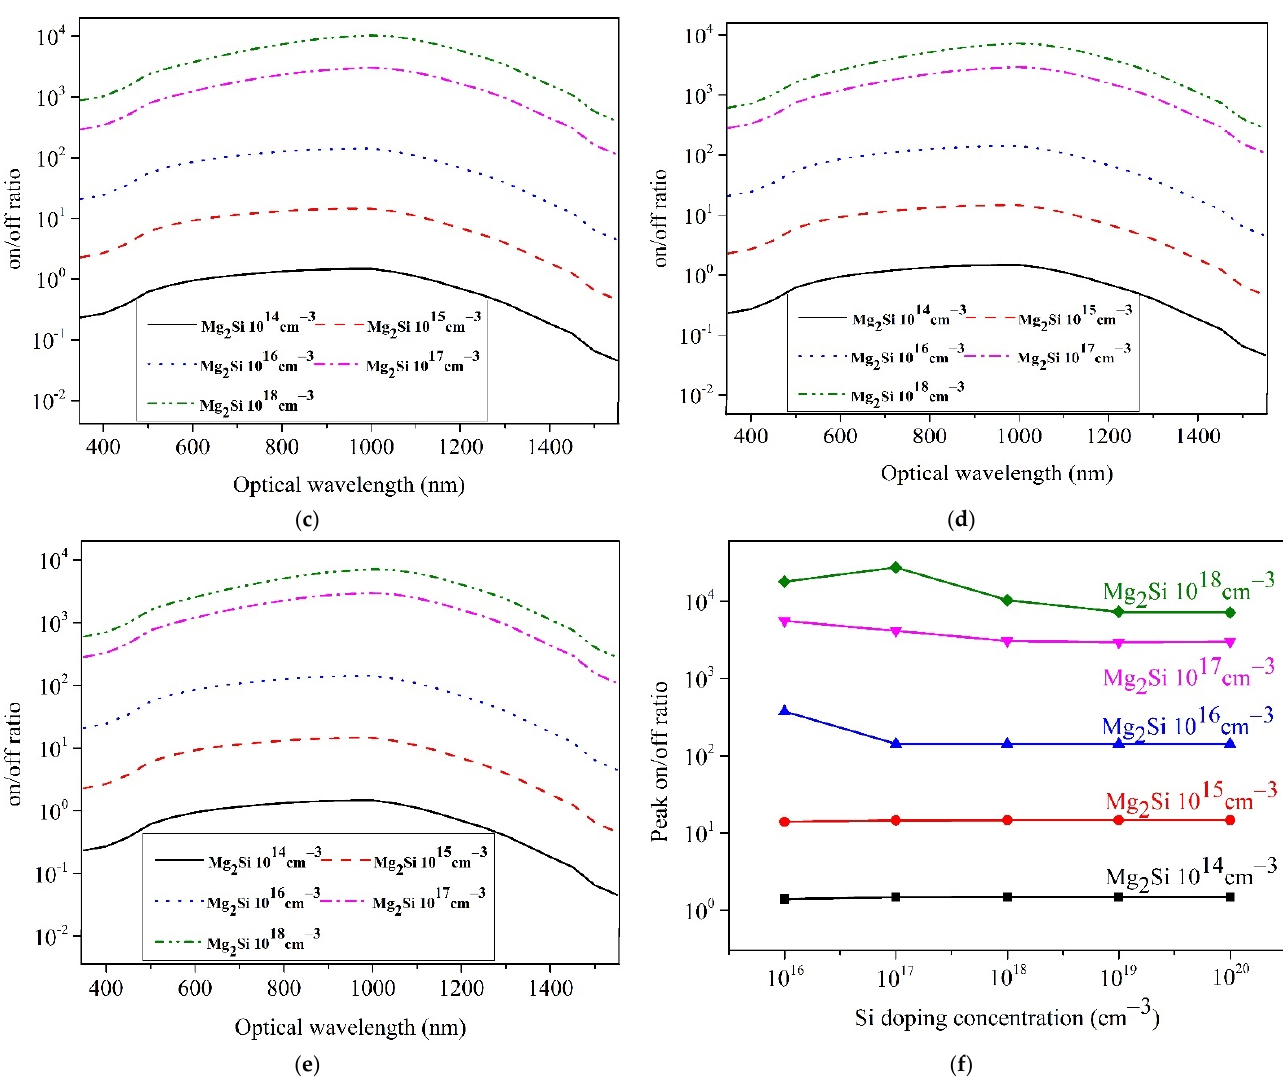
Figure 10. On/off ratio curves of the heterojunction PDs with different doping concentrations. ( a ) Si–10 16 cm − 3 . ( b ) Si–10 17 cm − 3 . ( c ) Si–10 18 cm − 3 . ( d ) Si–10 19 cm − 3 . ( e ) Si–10 20 cm − 3 . ( f ) The effect of doping concentrations on on/off ratio.